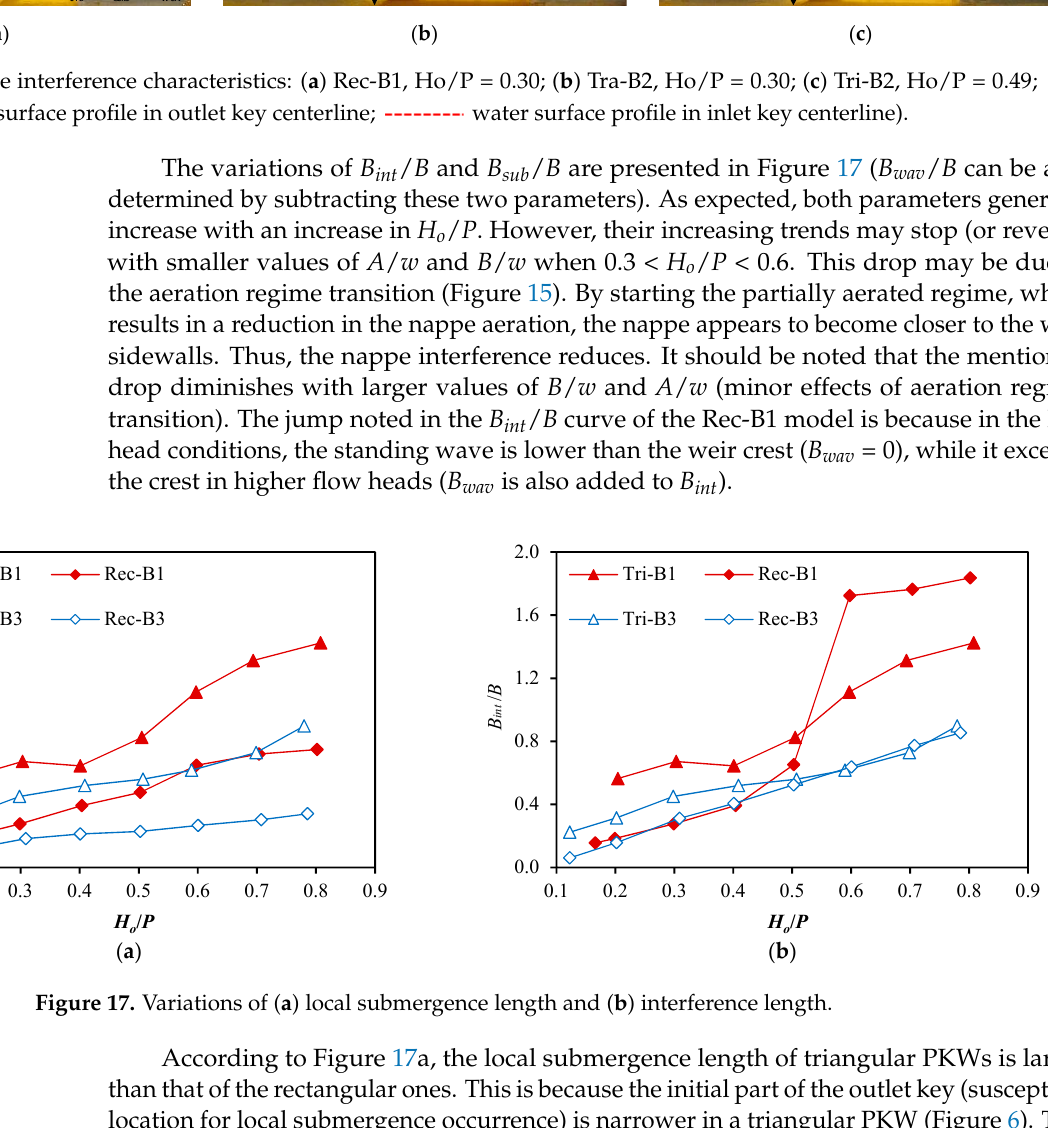
Figure 17. Variations of ( a ) local submergence length and ( b ) interference length.